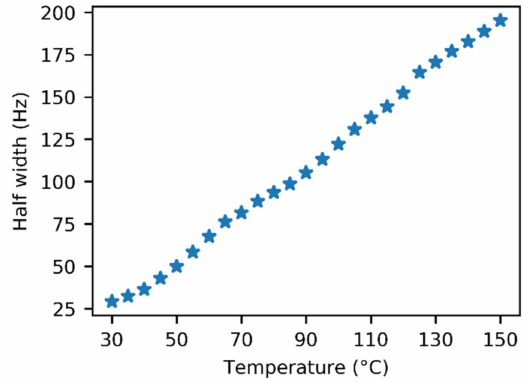
Figure 3. Temperature dependence of the half width of the 1 H–NMR signal of the acetic acid COOH group in the glass